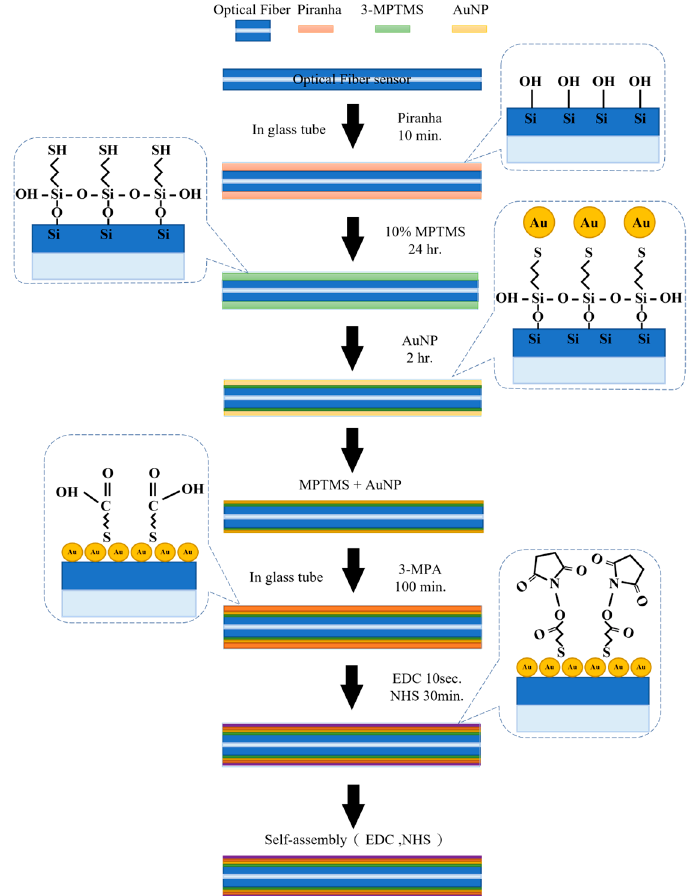
Figure 3. Experimental procedures for piranha solution etching, gold nanoparticle, 3-MPA, and EDC/NH self-assembly.